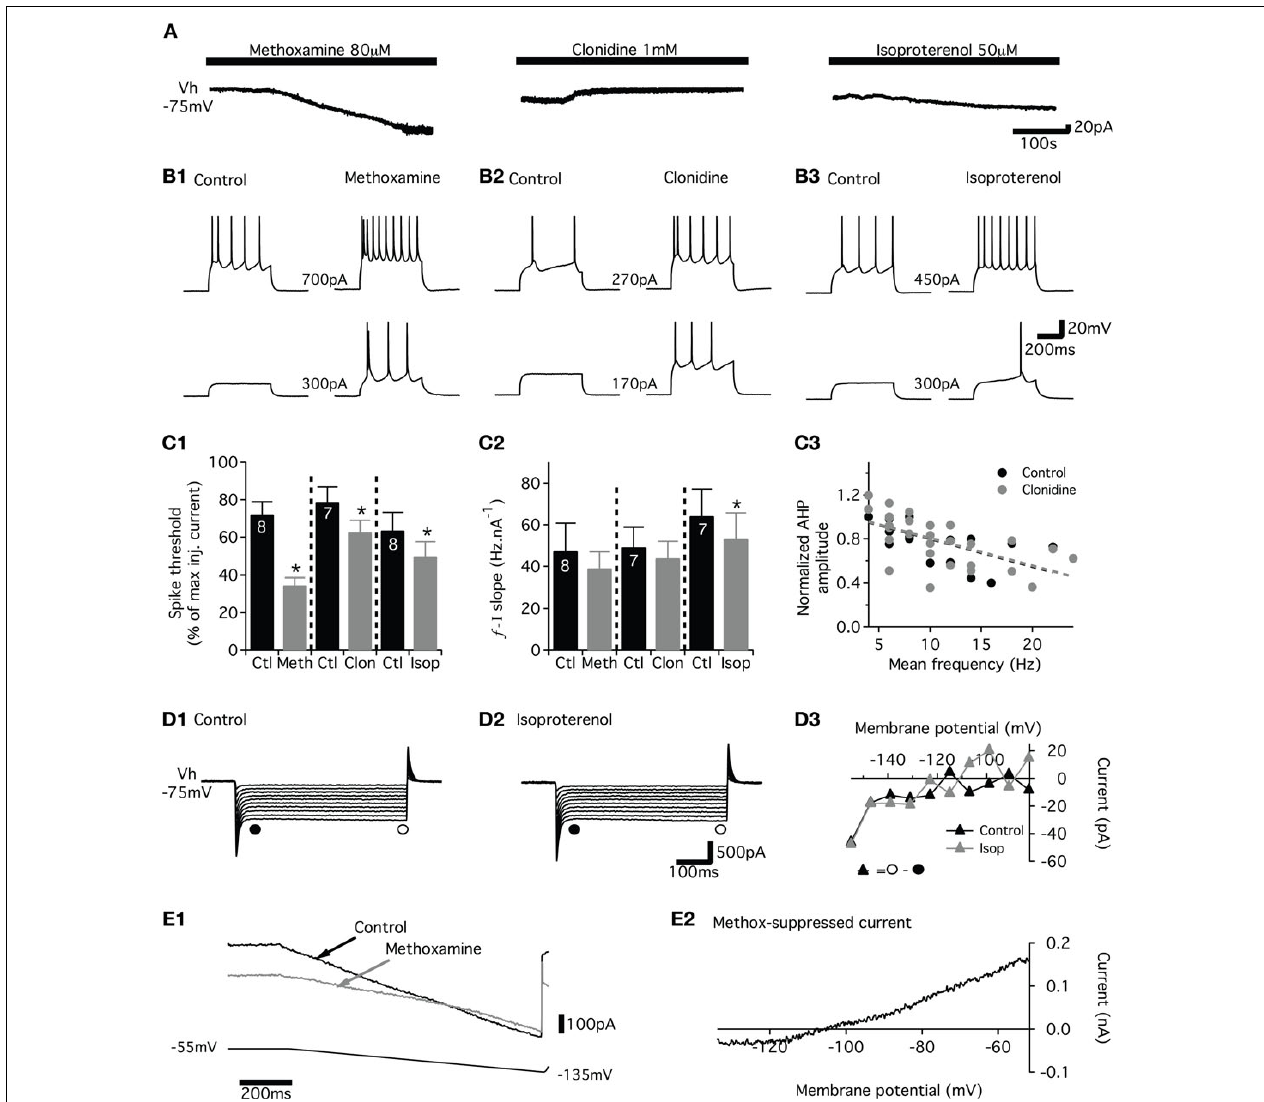
FIGURE 4 | Effects of the adrenoreceptor agonists on the membrane properties of the lumbar motoneurons. (A) Representative traces of the effects of methoxamine, clonidine and isoproterenol on the membrane potential of motoneurons held at − 75 mV (Vh). (B) Representative traces of both the spike frequency and the threshold for spike generation during depolarizing current pulses (current value between the traces) in the absence and presence of methoxamine (B1) , clonidine (B2) and isoproterenol (B3) . (C,C1) Summary histograms of the spike threshold computed as the percentage of the maximum injected current needed to evoke spiking in the presence of methoxamine (Meth), clonidine (Clo) and isoproterenol (Iso) compared to control condition (Ctl). (C2) Summary histograms of the slopes of the frequency current (f–I) relationship in the absence (fi lled bars) or presence of the noradrenergic